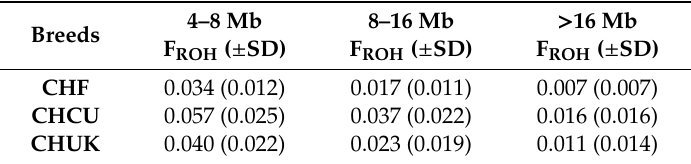
F ROH : Genomicinbreedingobtainedfromrunsofhomozygosity(ROHs)of4–8,8–16,and > 16Mb. ± SD:standarddeviation.